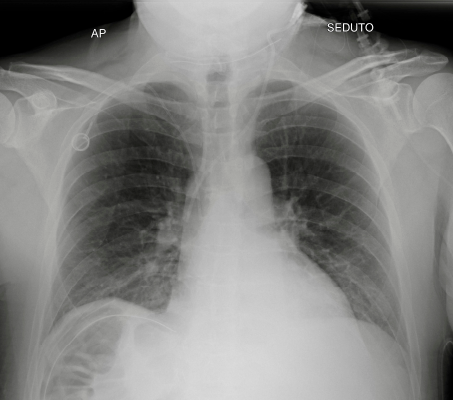
Figure 7. A normally placed PORT catheter with tip at the level of the SVC. Note a left jugular CVC with tip at the same level.